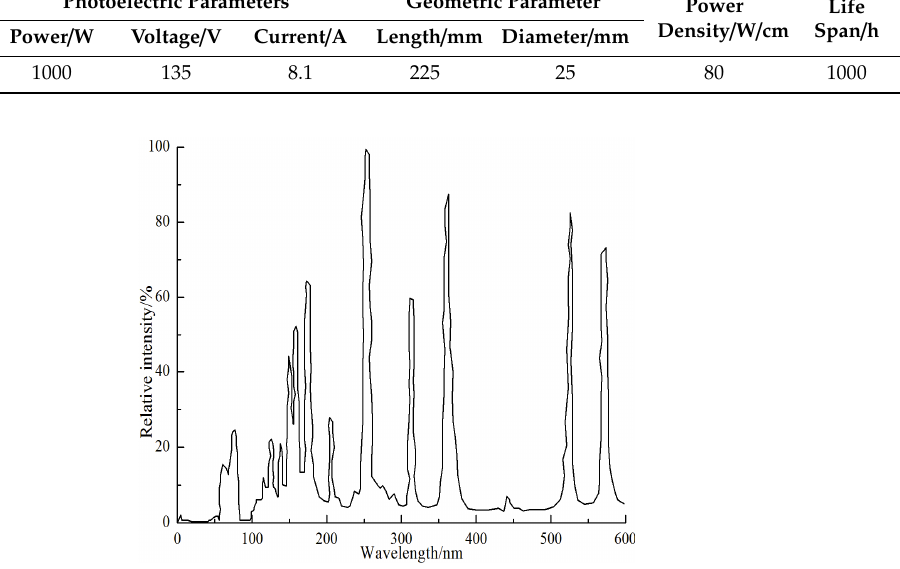
Figure 1. Light spectrum.